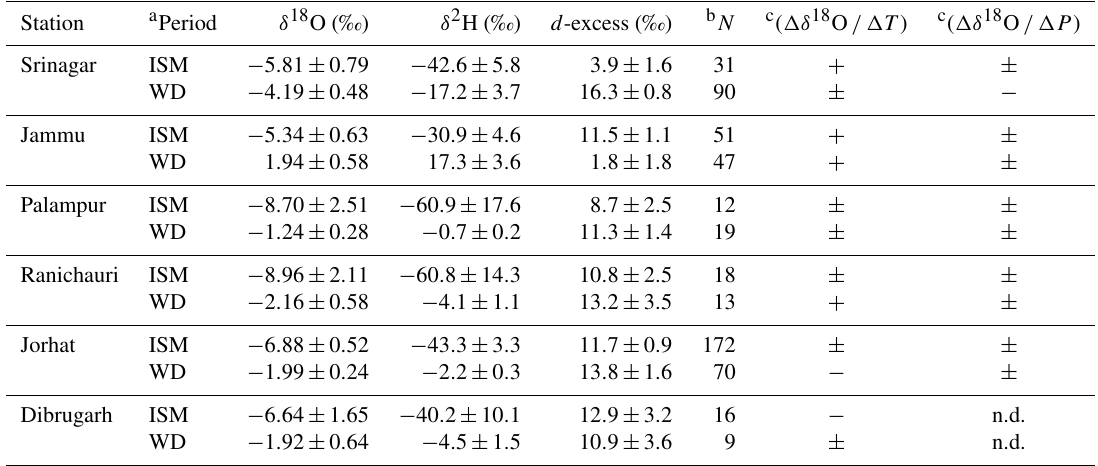
Table 3. Mean isotope characteristics of daily precipitation collected at the six stations along southern foothills of the Himalayas, calculated for the Indian summer monsoon (ISM) and western disturbances (WD) periods. Slopes of the best fit lines approximating the relationship between surface air temperature ( (cid:49)δ 18 O /(cid:49)T ) and precipitation amount ( (cid:49)δ 18 O /(cid:49)P ), based on daily data available for each period, are reported in the last two columns of the table. δ 18 O